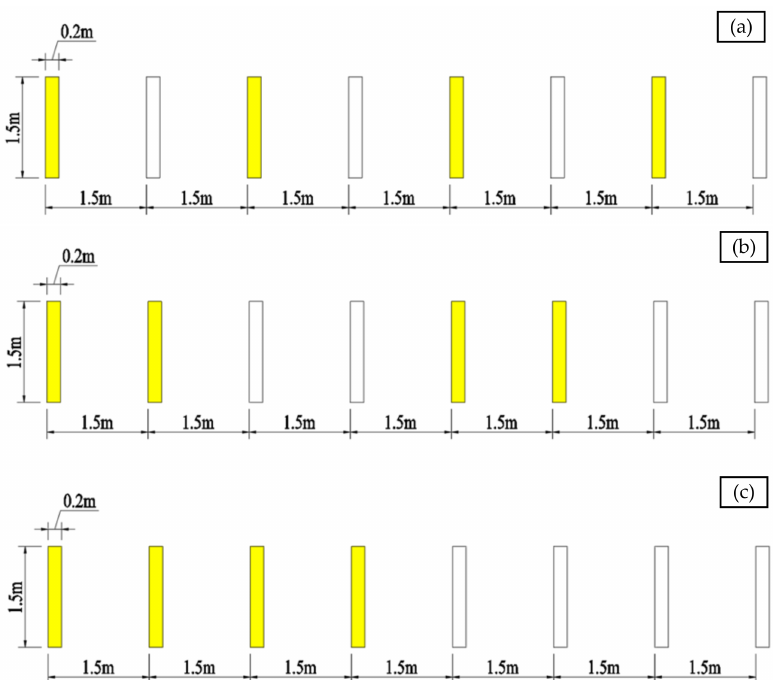
Figure 5. Schematics of alternating-color VIDD: ( a ) one yellow then one white (1Y1W); ( b ) two yellows then two whites (2Y2W); ( c ) four yellows then four whites (4Y4W).